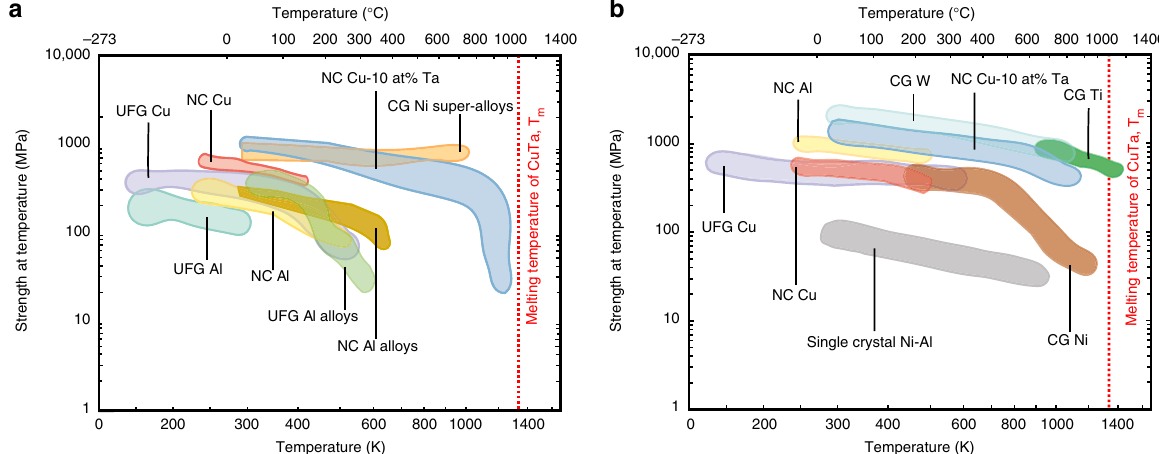
Fig. 5 Strength at temperature vs. applied temperature for NC and UFG metals and alloys. Yield strength and fl ow strength for NC-Cu-10 at.% Ta ’ s data along with NC and UFG data reported in the literature at a quasi-static and b high strain rates. The rate of change of strength with temperature is lower for NC-Cu-10 at.% Ta as compared to other NC materials reported. Literature data are from ref.